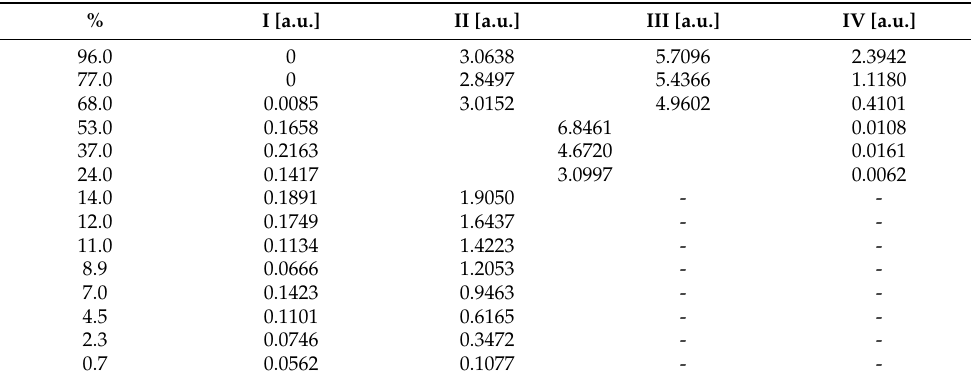
Table 1. Contributions to the signal from different water locations in MCM-41 obtained from the respective integrals of the ILT spectra, expressed in [a.u.] for: I—OH groups, II—intra pore water, III—inter pore water, IV—free water.